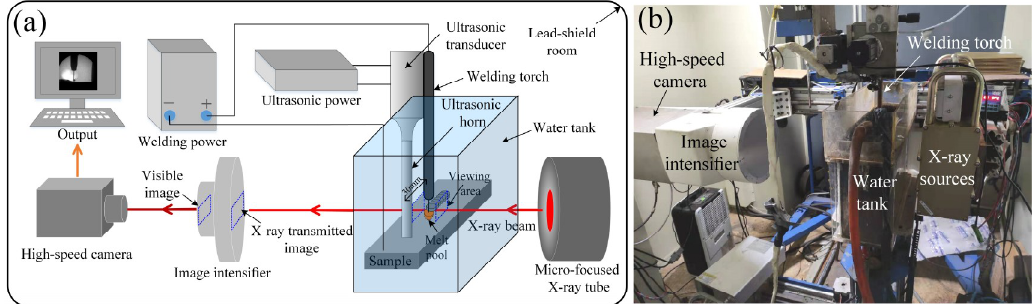
Figure 1. ( a ) Schematic diagram of the experimental setup. ( b ) The experimental platform in a lead-shield room.